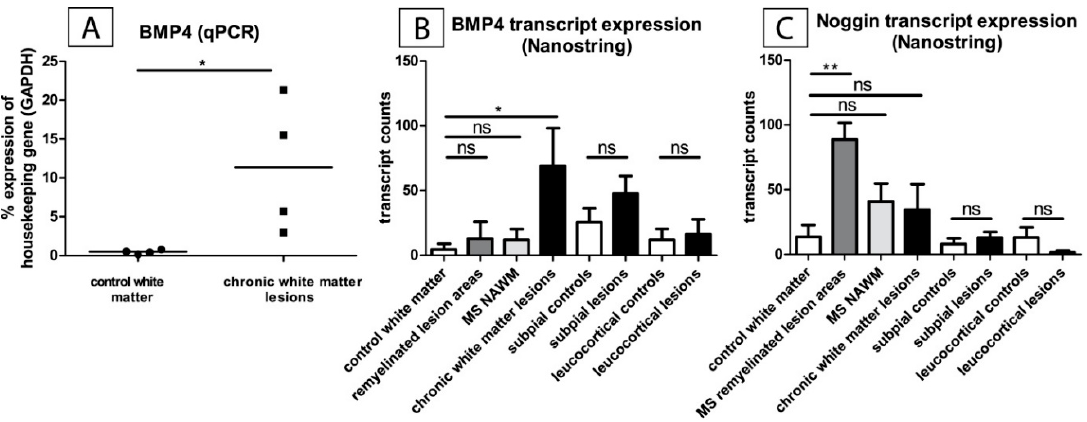
Figure 1. Bone morphogenetic protein4 (BMP4) expression and Noggin expression in multiple sclerosis lesions. ( A ) BMP4 is upregulated in chronic white matter lesions. The values were obtained by qPCR from frozen tissue RNA from four different multiple sclerosis (MS) patients and four controls. Glyceraldehyde 3-phosphate dehydrogenase (GAPDH) was used as a housekeeping gene. The Mann-Whitney rank sum test was applied for statistical analysis. (* p < 0.05). ( B , C ) Upregulation of BMP4 in chronic white matter MS lesions and upregulation of BMP4 antagonist Noggin in remyelinated lesion areas. The results were obtained using nanostring technology from RNA obtained from macrodissected lesion areas of formalin-fixed and paraffin-embedded autopsy (FFPE) tissue. GAPDH and beta-2 microglobulin (B2M) served as housekeeping genes for comparison. The point of reference for the statistical analysis (Mann-Whitney rank sum test) was always the corresponding control tissue of the white or grey substance (* p < 0.05 ( B , control white matter: n = 8, remyelinated lesion areas: n = 5, MS NAWM: n = 7, chronic white matter lesions: n = 9, subpial controls: n = 8, subpial lesions: n = 11, leukocortical controls: n = 8, leukocortical lesions: n = 9) and ** p < 0.01 ( C , control white matter: n = 8, remyelinated lesion areas: n = 5, MS NAWM: n = 7, chronic white matter lesions: n = 9, subpial controls: n = 8, subpial lesions: n = 11, leukocortical controls: n = 8, leukocortical lesions: n = 9), mean + SEM).